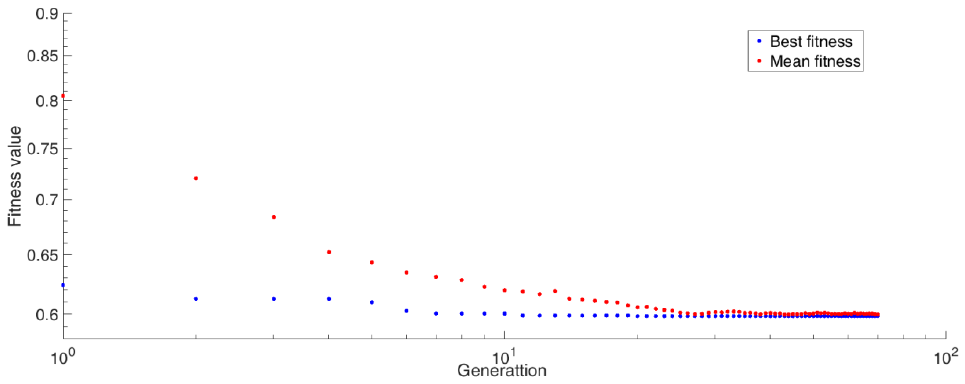
Figure 6. The convergence process of fitness function value. Table 4. Parameters of the designed materials for different weight factors and results of the compared materials.